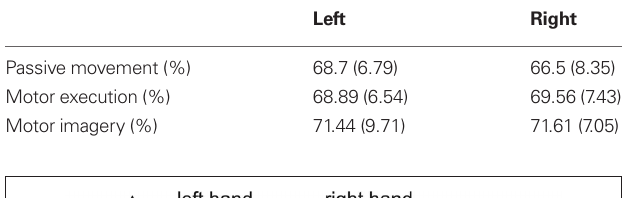
Table 1 | Mean and SD of classification accuracies in detecting motor imagery for classifiers calculated with data of different